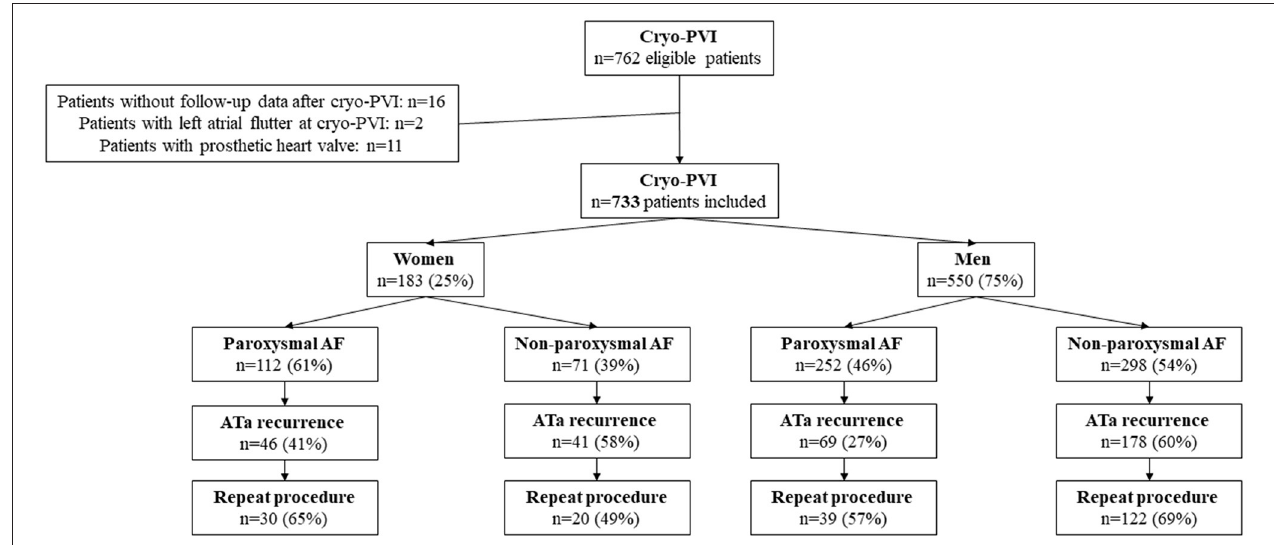
FIGURE 1 | Study flow